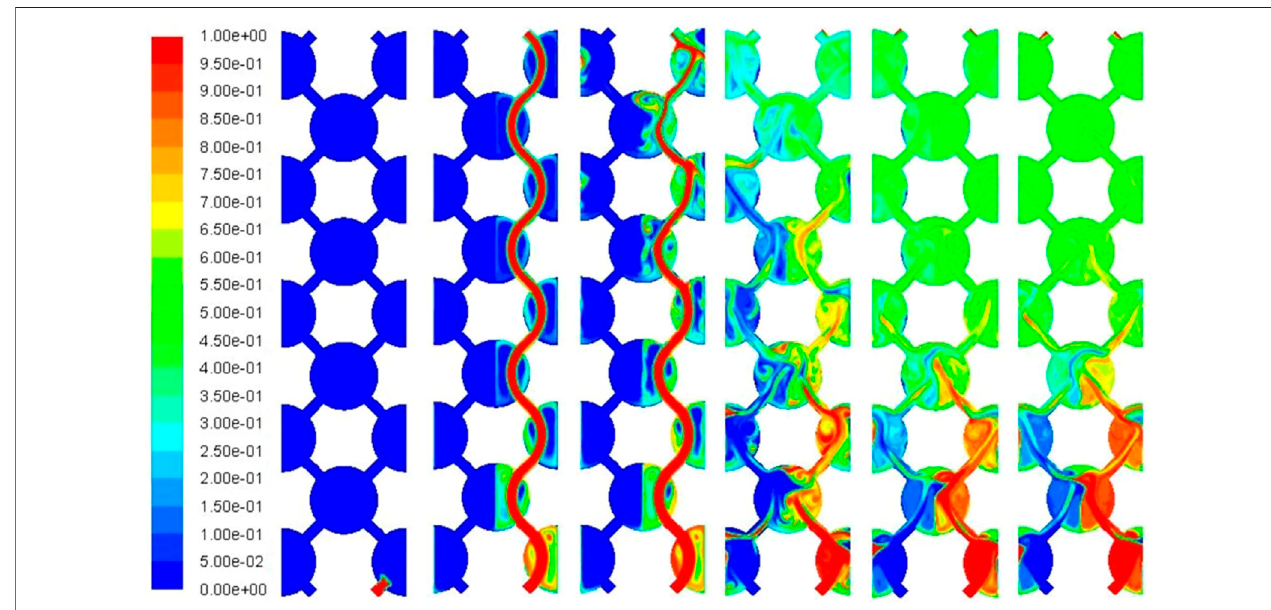
FIGURE 12 | Molar fraction of Fluid2 in the ExtendedNUB geometry, for Re (cid:1) 300, at: (A) 0.034 s, (B) 0.94 s, (C) 1.95 s, (D) 2.63 s, (E) 3.52 s and (F) 5.69